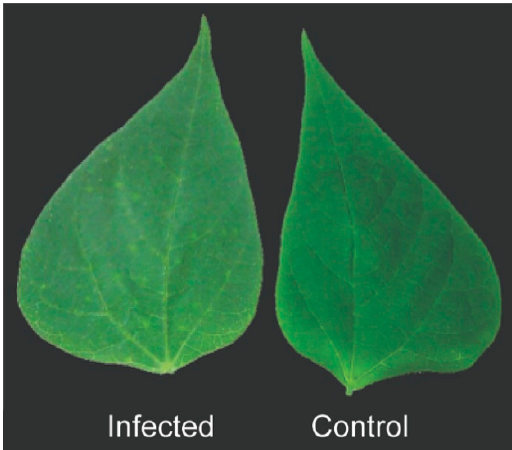
Figure 7. Common bean ‘BRS FC 401 RMD’ leaves from whitefly mediated BaCV and CPMMV transmission. Mild mottling and chlorotic spots in a leaf of an infected plant at ~50 days after inoculation and the leaf of a non-infected control